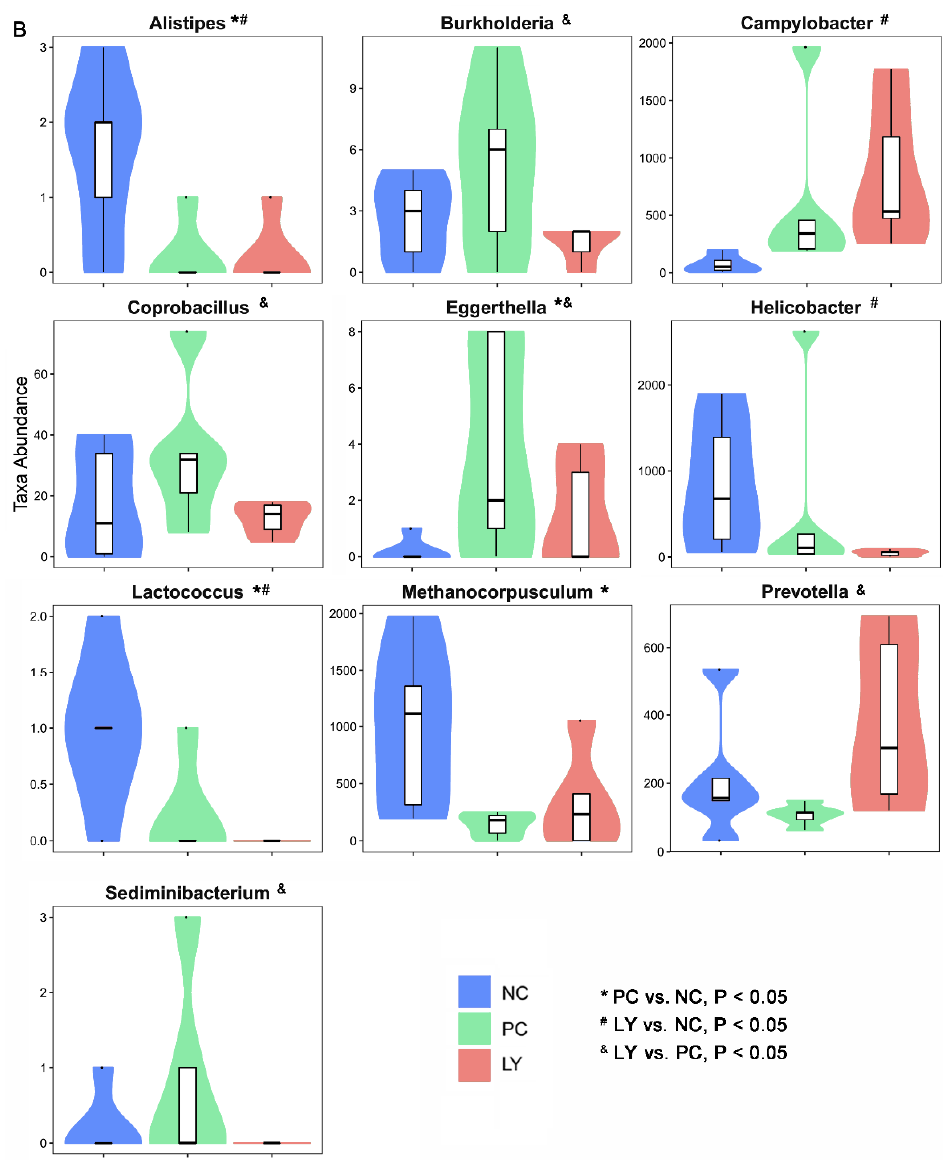
Figure 3. Different species at the phylum ( A ) and genus ( B ) level in the cecal microbiota of broilers. NC—negative control, basal diets; PC—positive control, basal diets supplemented with antimicro- bials; LY—basal diets supplemented with compound probiotics. * significant difference ( p < 0.05) between PC and NC groups. # significant difference ( p < 0.05) between LY and NC groups. & signifi- cant difference ( p < 0.05) between LY and PC